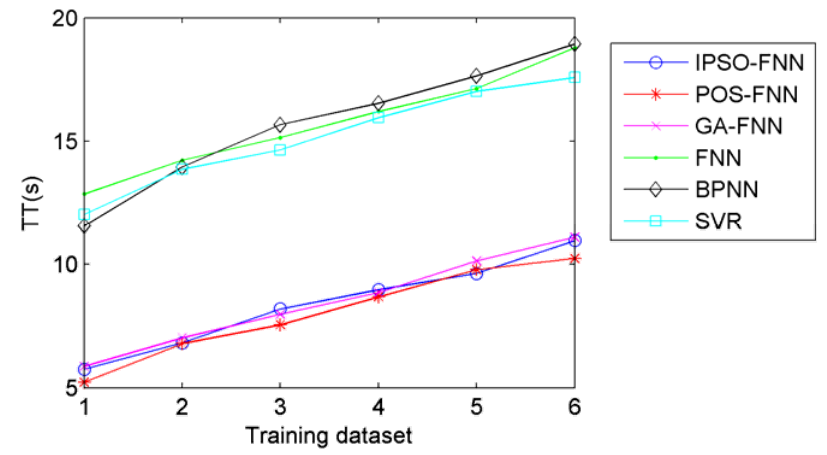
Figure 8. Comparison of training time.